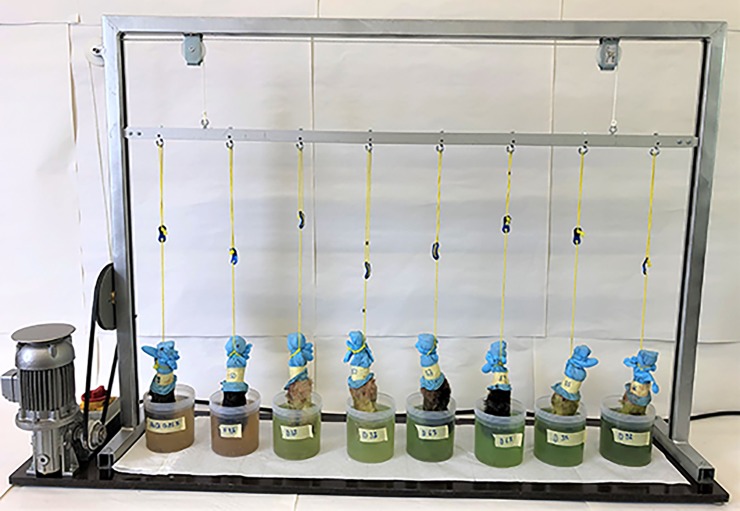
Foot-dipping machine.The foot-dipping machine simulates the movement of alive sheep feet in disinfectant footbath solution.